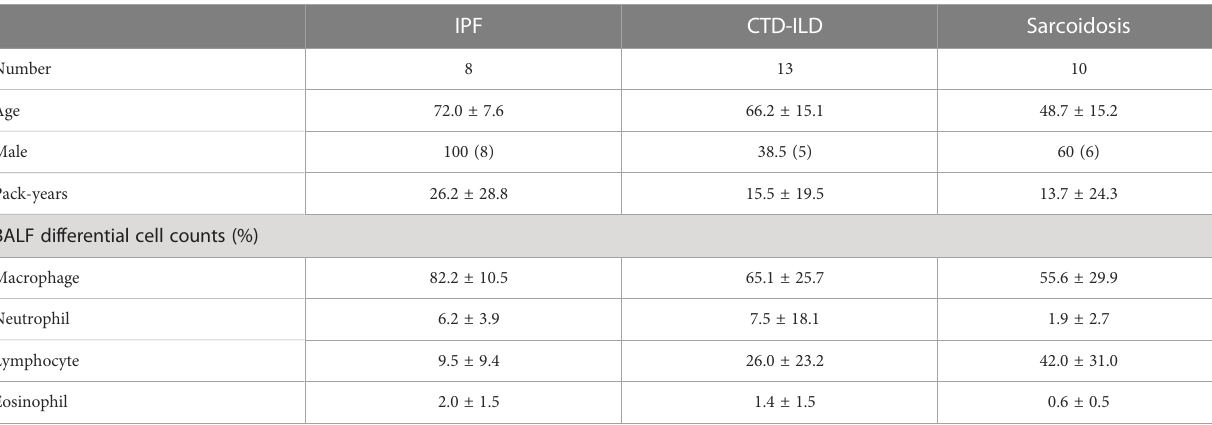
TABLE 1 Characteristics of the study